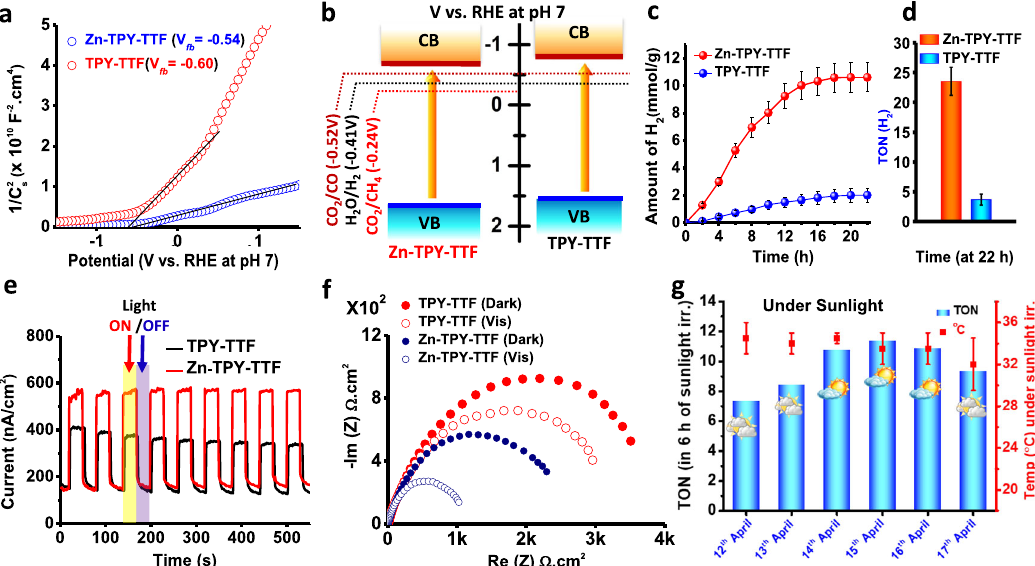
Fig. 5 Electrochemical characterization and photocatalytic H 2 production performances for TPY-TTF OG and Zn-TPY-TTF CPG. a Mott-Schottky plot w.r.t. RHE at pH = 7 (at 1000 Hz, − 1.5 to + 1.5 V). b Band alignment based on Mott-Schottky plot (V vs RHE at pH = 7; valence band (VB) and conduction band (CB)). c Amount of H 2 evolution under visible light and d corresponding TON (for H 2 ) at 22 h. (Error bars in panels c and d represents the standard deviations of three catalytic runs). e Photocurrent measurement in 0.5 M Na 2 SO 4 at + 0.8 V, pH ~7 upon visible-light irradiation in the time interval of 30 sec. f Nyquist plot under light and dark condition. g TON (for H 2 ) for Zn-TPY-TTF CPG under direct sunlight irradiation from 12th to 17th April 2019 (10:00 am to 4:00 pm) and the error bars represents the temperature range of photocatalytic set-up during catalysis under the sunlight irradiation. (Note: all visible-light experiments were performed under 300 W Xenon lamp using visible bandpass fi lter; 400 –